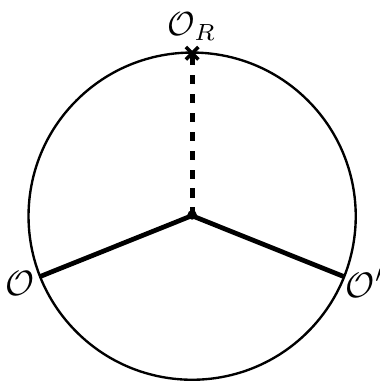
Figure 2 . Witten diagram for the CFT Wightman function hOO R O 0 i . The solid lines for the two external operators represent Wightman bulk-to-boundary propagators, while the dashed line for the middle operator represents a time-ordered